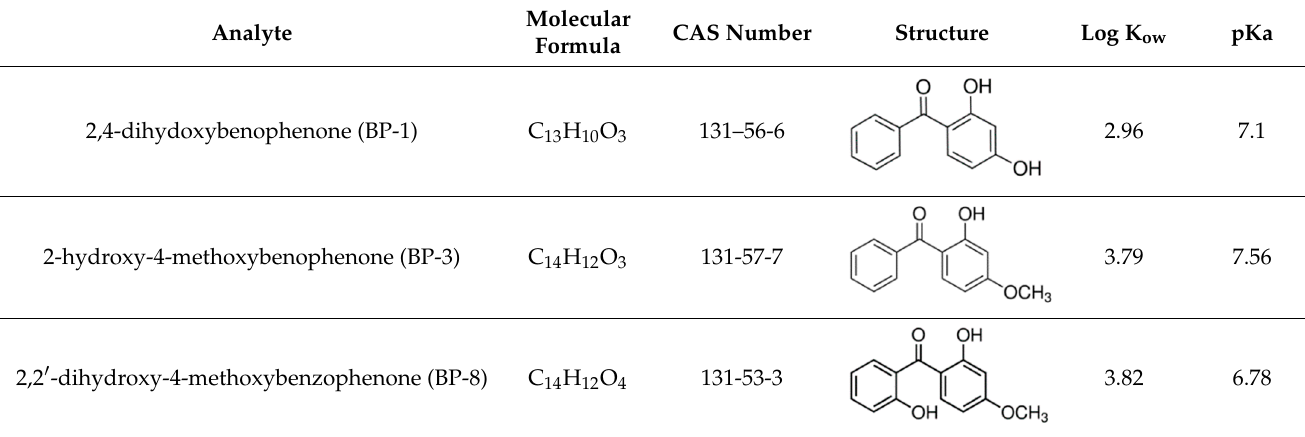
Table 6. Characteristics of the UV filters studied.